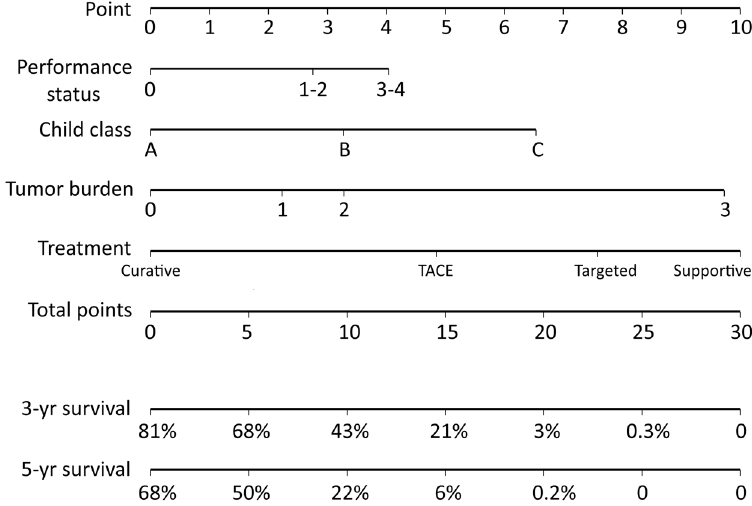
Figure 2. Nomogram predicting 3- and 5-year survival of HCC patients in the derivation set. The nomogram is used by adding up the points identified on the scales of these 4 parameters. The total nomogram point of each patient can be used to predict the probability of survival at 3 and 5 years.